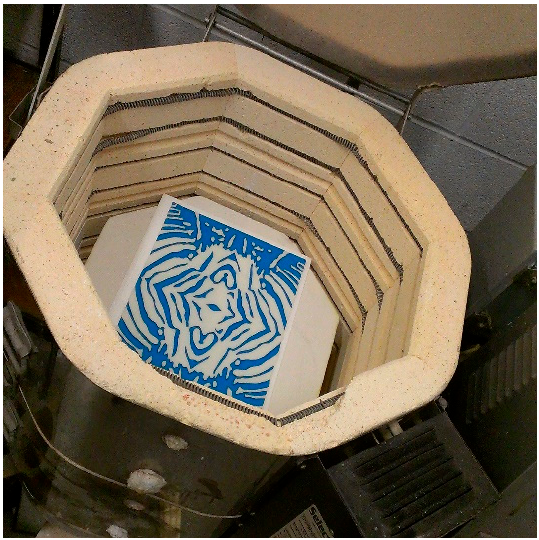
Figure 5. Reassembled sheet glass pattern on single glass pane ready to fire and fuse. [Created by author].